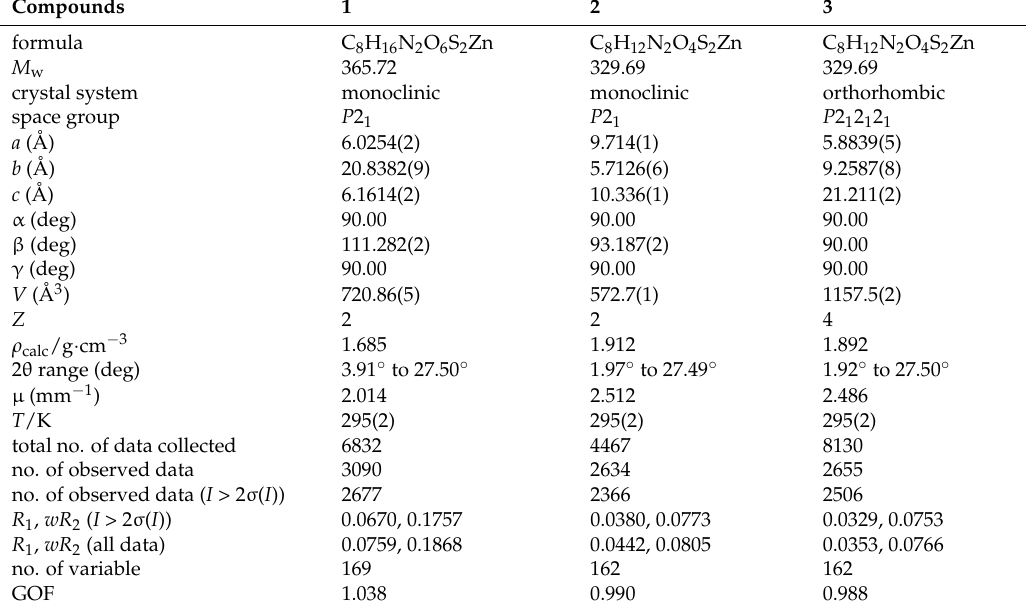
Table 1. Crystal data and refinement details of 1 –